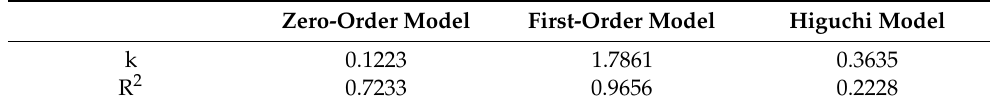
Table 2. Some key parameters for the three drug release models.